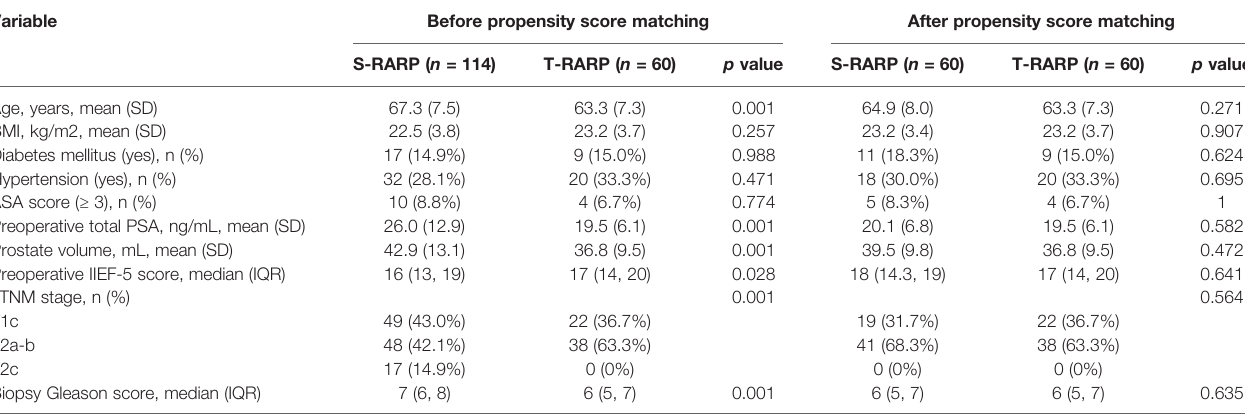
TABLE 1 | Preoperative characteristics by surgery type before and after propensity score matching.